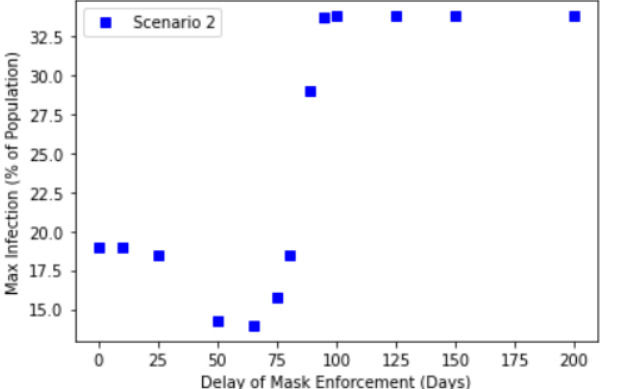
Figure 7. Maximum infection against delay in mask enforcement for Scenario 2: SEIR with gradual noncompliance for the B117 variant